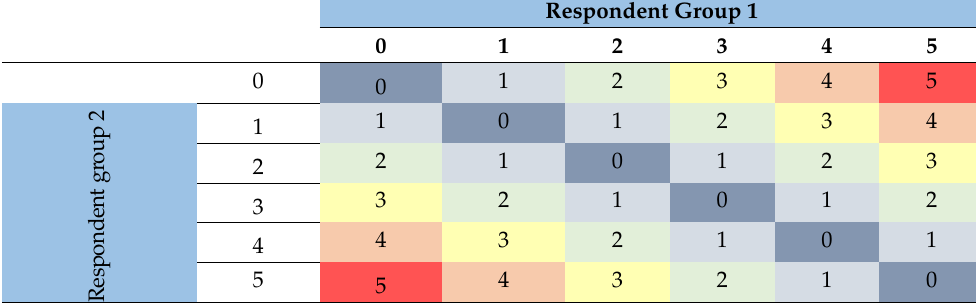
Figure 6. Cross-tabulation maps and matrices . The results of cross-tabulation analysis and the difference between models of the per- ception of landscape potential for development (see maps and tables in Figure 7) show that the absolute difference in the perception of the potential between hunting and agri- culture experts on 81.36% of the area is 0, that is, there is no difference. However, in the comparison of the model and both groups of respondents with the model of experts in the field of nature protection, the results indicate that the absolute difference is 0 (perceived as equally valuable) in less than 10% of the area. (Simultaneously, on the majority of the